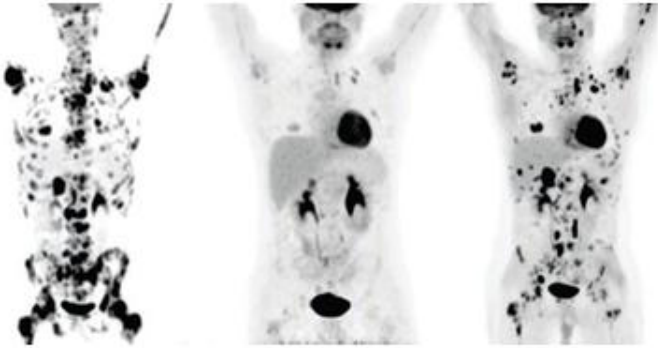
Figure 13. Dramatic but transient effect of new cancer treatment drug. Within two months, a novel drug candidate shriveled a man’s metastasized cancer (center). One month later, the cancer, now resistant, resurged. Permission granted from The New England Journal of Medicine; Rudin et al. [140].